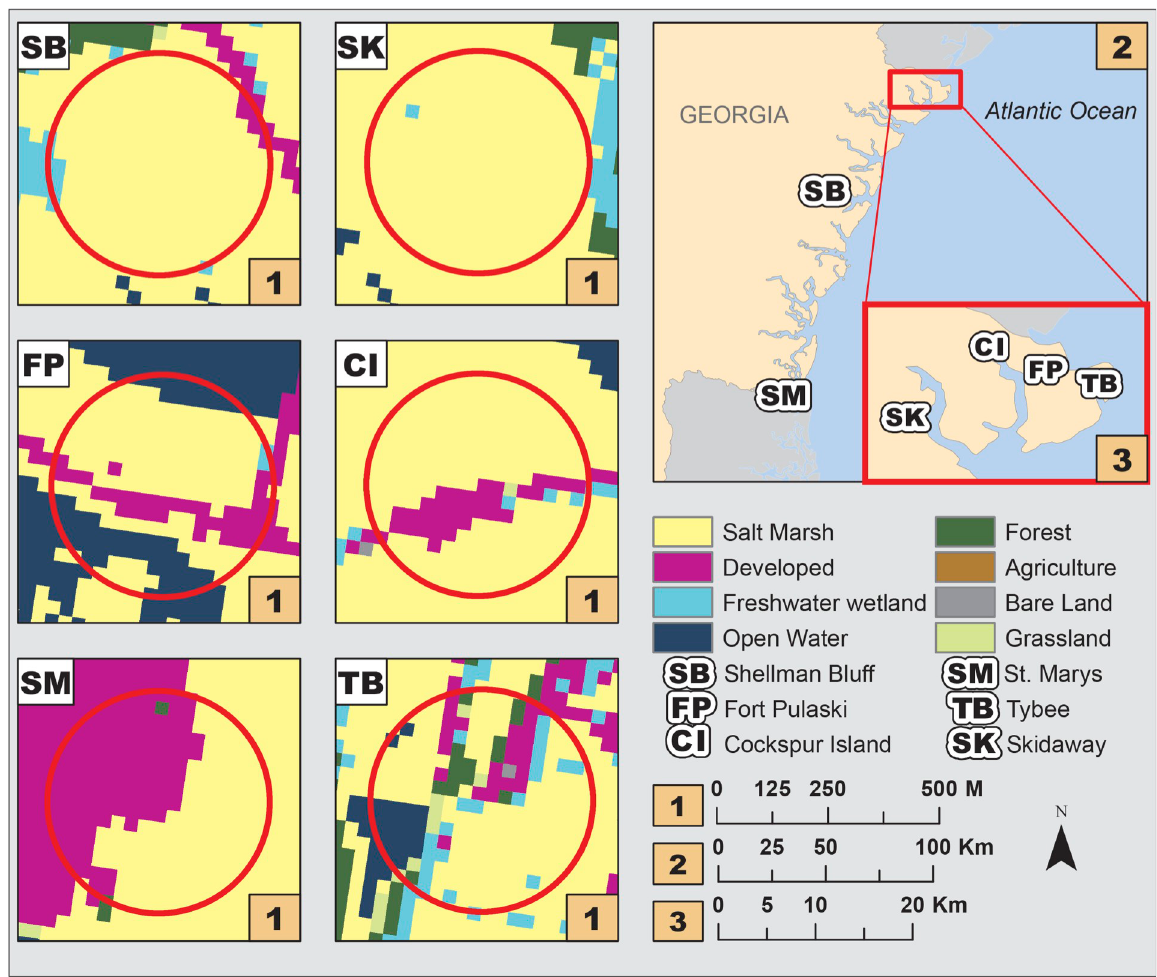
Fig 1. Map of 6 salt marsh study sites in coastal Georgia, USA with 2011 land cover data. The sites include Fort Pulaski (FP), Cockspur Island (CI), Tybee (TB), and Skidaway Island (SK) in the Savannah River Estuary; Shellman Bluff (SB) as a representative of the Sapelo Sound; and St. Marys (SM) as part of the St. Marys Estuary. Red circles represent a 250 m buffer around the study site. For the purpose of this work, land cover data was reclassified from the original 21 categories to 10 (Salt Marsh, Developed, Freshwater Wetland, Open Water, Forest, Agriculture, Bare Land, and Grassland): 2 land cover categories were not present in the study area (Freshwater Aquatic Bed and Unconsolidated Shore).